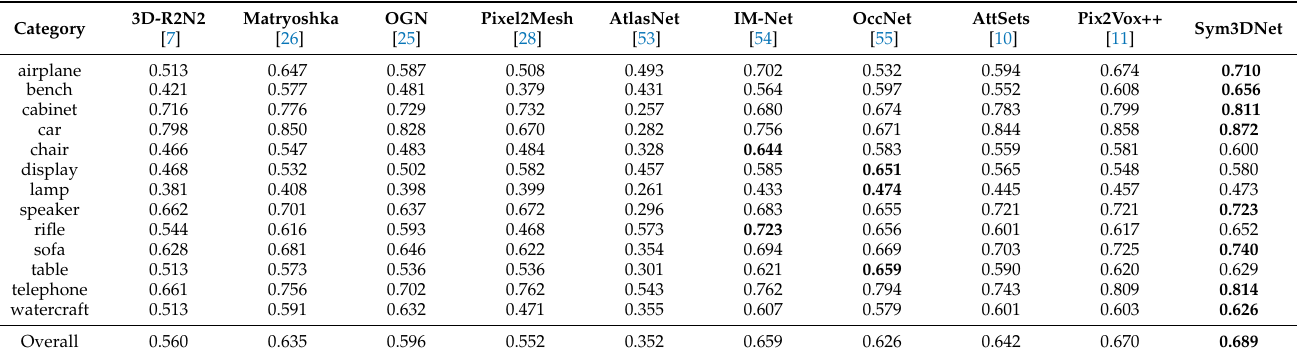
Table 4. Comparison of 3D shape reconstruction from single view on ShapeNet13. We provide Intersection of Union (IoU) scores per category. We provide the mean IoU of each category. For the best category, we highlight the scores in bold.